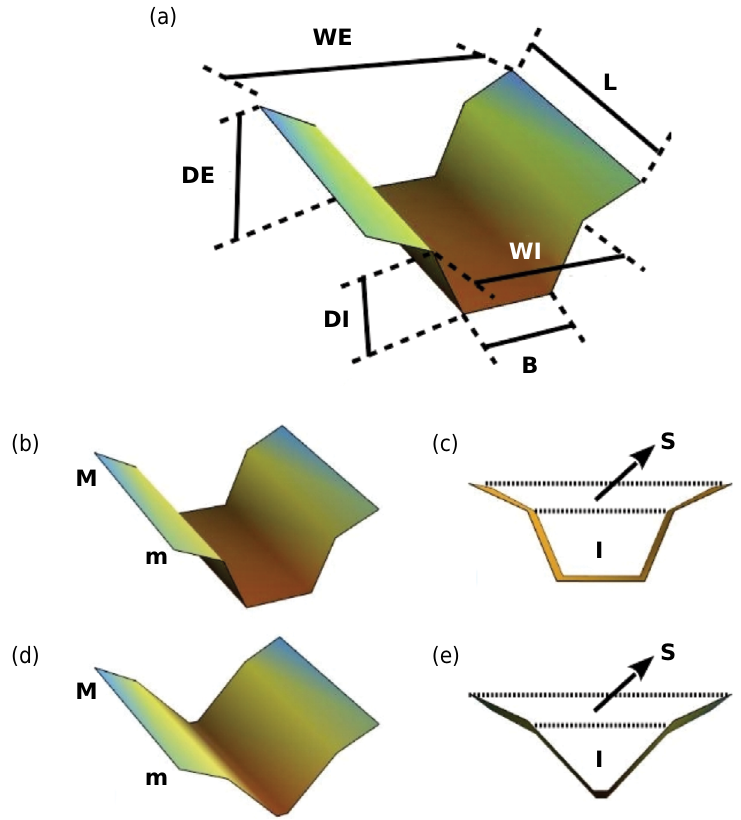
Figure 4. Representation of the section formed by two measured points of a linear erosion feature (LEF). (a) overview – WE (width of extreme points of the LEFs), WI (width inside the LEF), DE (depth from WE) , DI (depth from WI), L (distance between two measured points) and B (base); (b) and (c) show the perspective and frontal views of a U-shaped linear incision; (d) and (e) show the perspective and frontal views of a Vshaped linear incision. The points M and m represent the two points extremities from which the areas were taken. The letters S and I indicate the frontal view of the upper and lower trapezia,